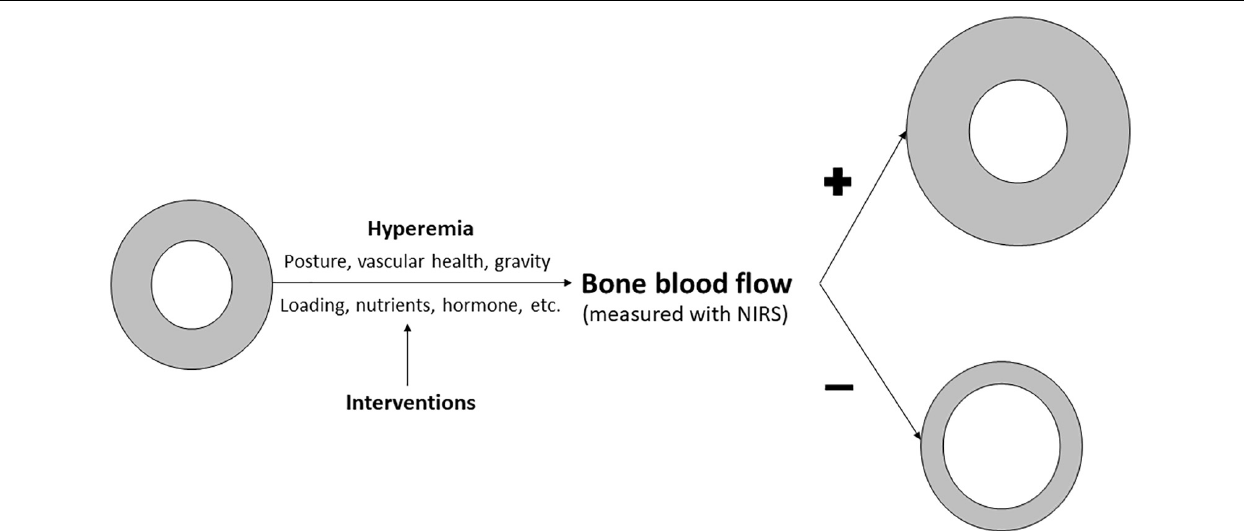
FIGURE 3 | Figure showing how NIRS may be used to assess bone health and monitor intervention studies designed to enhance bone quality. Existing evidence suggest that posture, gravity, vascular health can impact bone blood flow. There is some evidence and a growing interest in bone hyperemia, as induced either by laboratory vascular occlusion procedure or exercise/physical activity, on bone blood flow changes primarily due to its modifiable nature. In addition, interventions designed for better loading, nutrition or hormonal conditions in human can enhanced bone blood flow. We propose that enhanced bone blood flow, which can be monitored by NIRS, will lead to greater total bone size and cortical (gray ring) expansion, resulting in stronger bones, whereas poor bone blood flow induced by a lack of these stimulation factors could lead to poor bone development or even bone loss, resulting in less cortical bone.